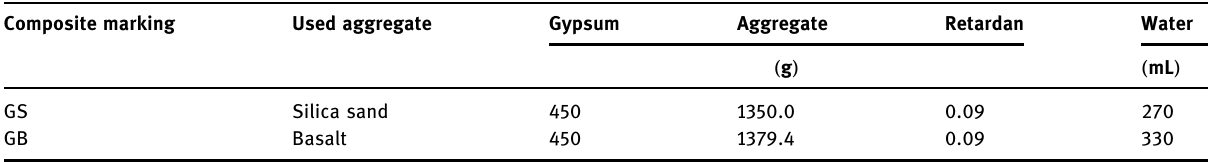
Table 4: Composition of tested materials ( amount for one batch ) Composite